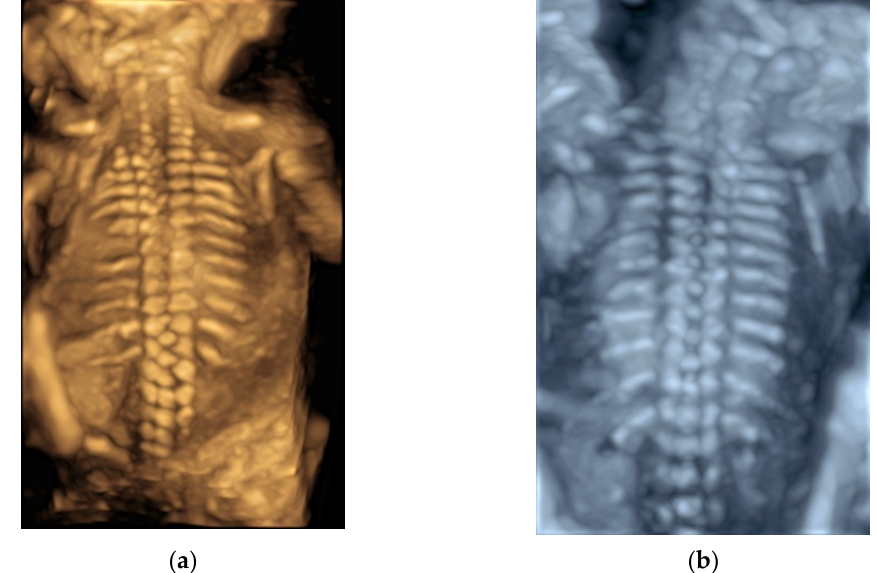
Figure 8. Three-dimensional rendered views of fetal spine at 20 weeks’ gestation after a volume acquisition with skeletal mode: ( a ) usual mode, and ( b ) X-ray mode.